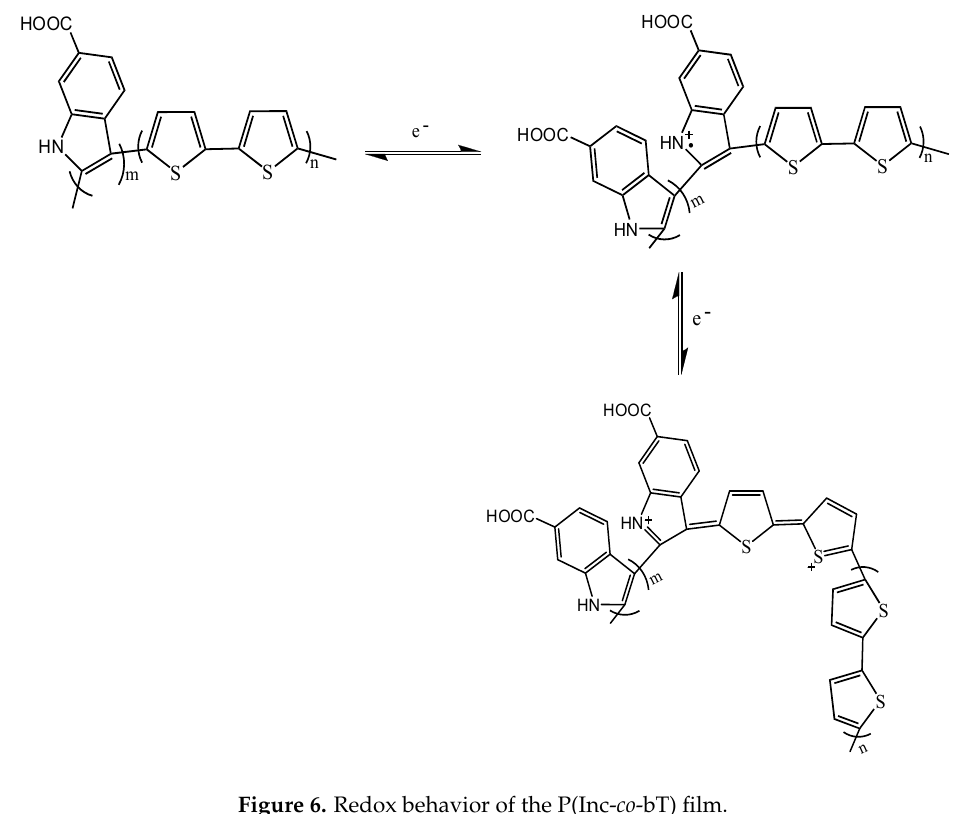
Figure 6. Redox behavior of the P(Inc- co -bT) film.